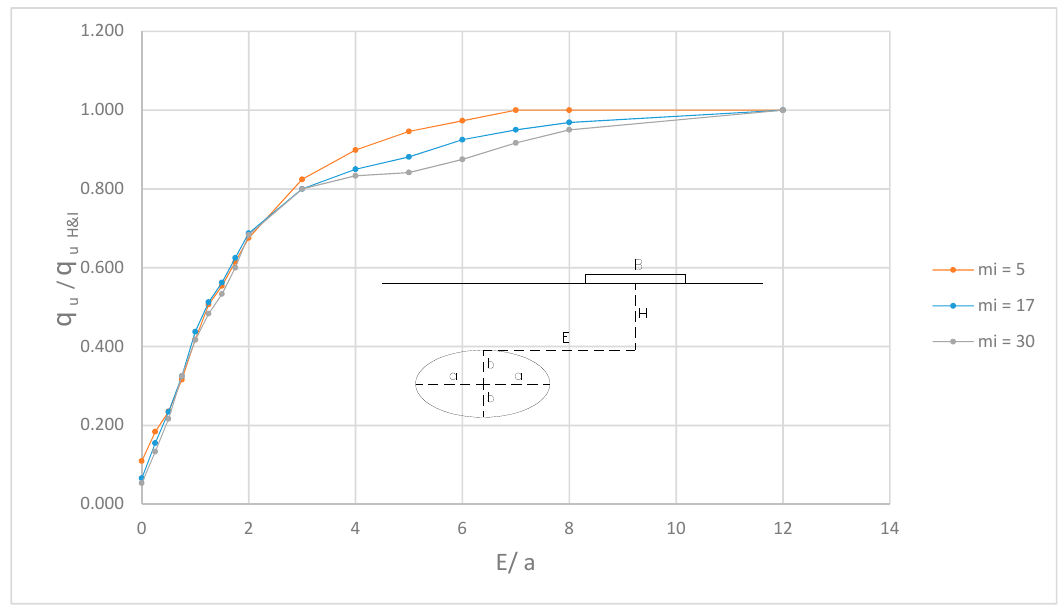
Figure 10. Influence of rock type (parameter m i ) on the ultimate bearing capacity when varying the load eccentricity.